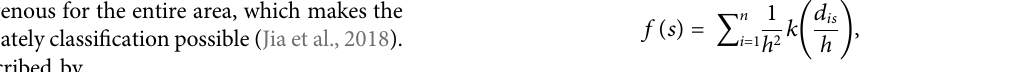
Frontiers in Environmental Science |